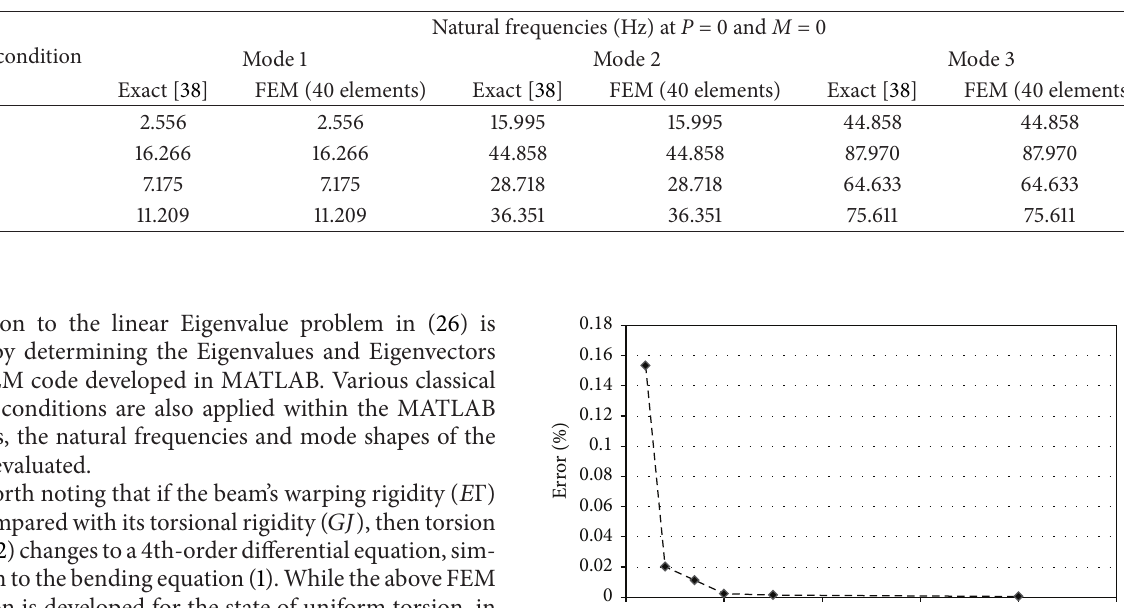
Table 1: FEM results versus exact data for the first three natural frequencies at 𝑃 = 0 and 𝑀 = 0.